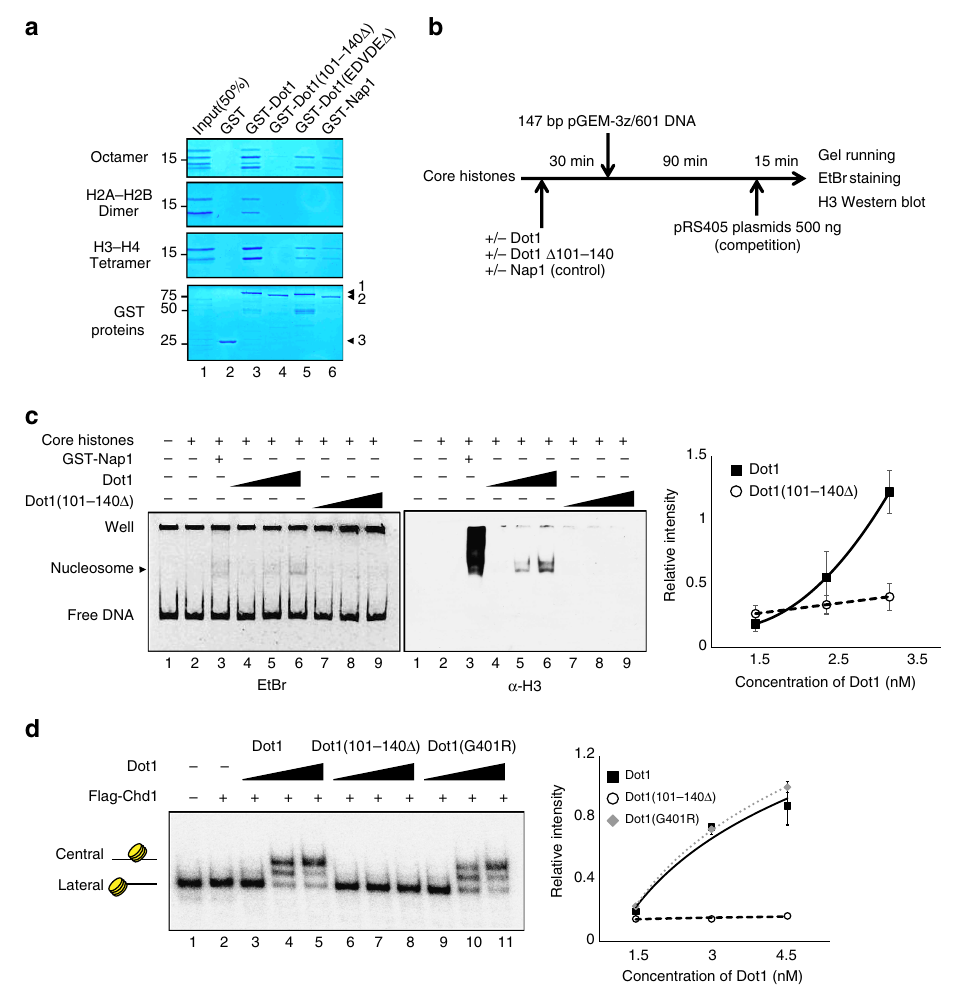
Fig. 4 Dot1p has nucleosome assembly activity and enhances chromatin remodeler activity. a Protein pull-down assay of GST-tagged Dot1 proteins against core histones. SDS-acrylamide gels were stained with Coomassie blue. The Octamer panel (top) indicates histone H2A, H2B, H3, and H4 for binding with GST (negative control), GST-Dot1, a nucleosome binding-defective mutant GST-Dot1 ( 101 – 140 Δ ), a histone H4 tail binding-defective mutant GST-Dot1 ( EDVDE Δ ), and GST-Nap1 proteins. The H2A – H2B dimer (second panel) represents band size of histone H2A – H2B for each protein binding. The H3 – H4 tetramer panel (third panel) indicates size of histone H3 – H4 for each protein binding. The 5 μ g of GST fusion proteins were incubated with 10 μ g of histones in 200 μ l of PDB buffer for 2 h at 4 °C. In the bottom panel, arrows indicate the following: 1, GST-Dot1p, GST-Dot1p ( EDVDE Δ ), and GST-Dot1p ( 101 – 140 Δ ) (showing a smaller size); 2, GST-Nap1p; and 3, GST. b Experimental scheme of the in vitro nucleosome assembly assay. c Assay of the ability of Dot1 to assemble nucleosomes on a fragment of pGEM-3z/601 DNA. The 147 bp DNA fragment (100 ng) was incubated without (lane 1) or with (lanes 2 – 9) 1:1 mass ratios of core histones. The nucleosome assembly activities of wild-type Dot1 (1.5, 2.4, and 3.2 nM; lanes 4 – 6) and the nucleosome binding- defective mutant, Dot1(101 – 140 Δ ) (same concentrations as Dot1; lanes 7 – 9) are shown, with 2 μ g of GST-Nap1 used as a positive control for nucleosome assembly (lane 3). The arrow labeled with ‘ nucleosome ’ indicates size of assembled nucleosome. The nucleosome assembly was visualized with ethidium bromide (EtBr) staining (left) and histone H3 western blotting (center), and the data were quanti fi ed (right). The data are presented are averages of three experiments, and error bars represent the s.d. for the biological replicates. d The ability of Dot1 to stimulate chromatin remodeling does not require its methyltransferase activity. Sliding assays using the nucleosome remodeler, Chd1p, were performed with Dot1p (lanes 3 – 5), nucleosome binding-defective Dot1(101 – 140 Δ ) (lanes 6 – 8), and methyltransferase activity-defective mutant Dot1 (G401R) (lanes 9 – 11). The graph (right) indicates the relative intensities of the central nucleosome bands versus the Dot1 protein concentration. The data presented are the averages of three experiments, and error bars represent the s.d. for the biological